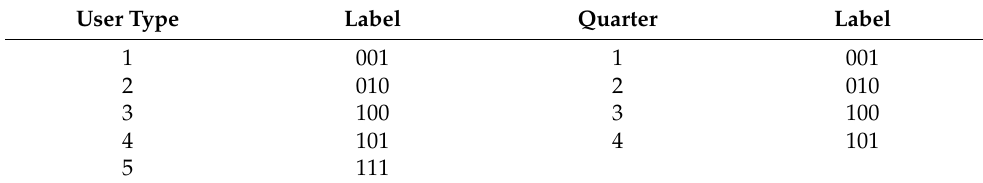
Table 7. User-type label.